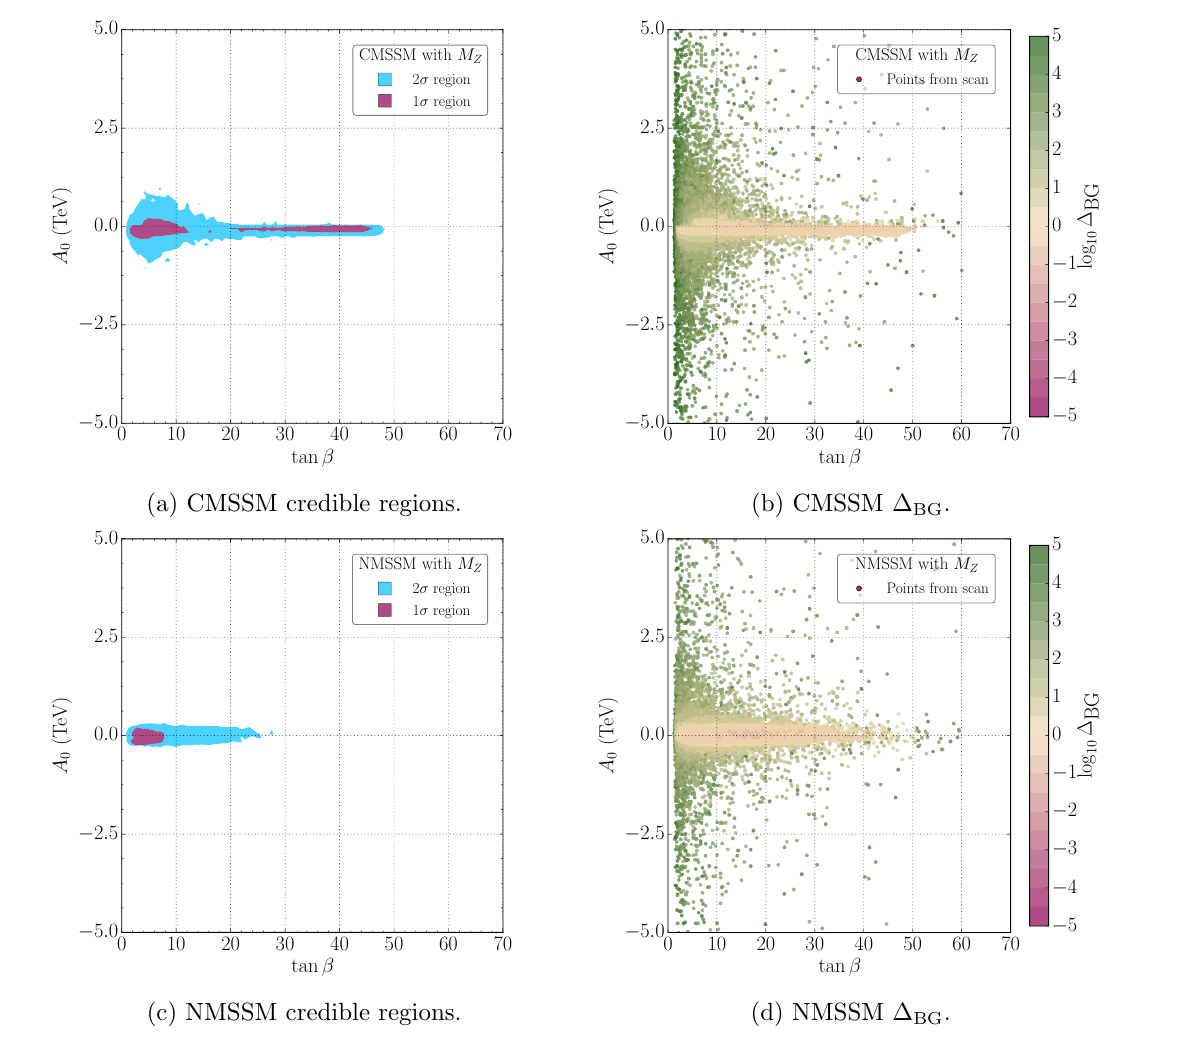
Figure 4. Credible regions of the marginalized posterior probability density conditioned upon M Z (left) and pro(cid:12)led BGEN measure (right) for the CMSSM (upper) and NMSSM (lower) on the (tan (cid:12) , A 0 )